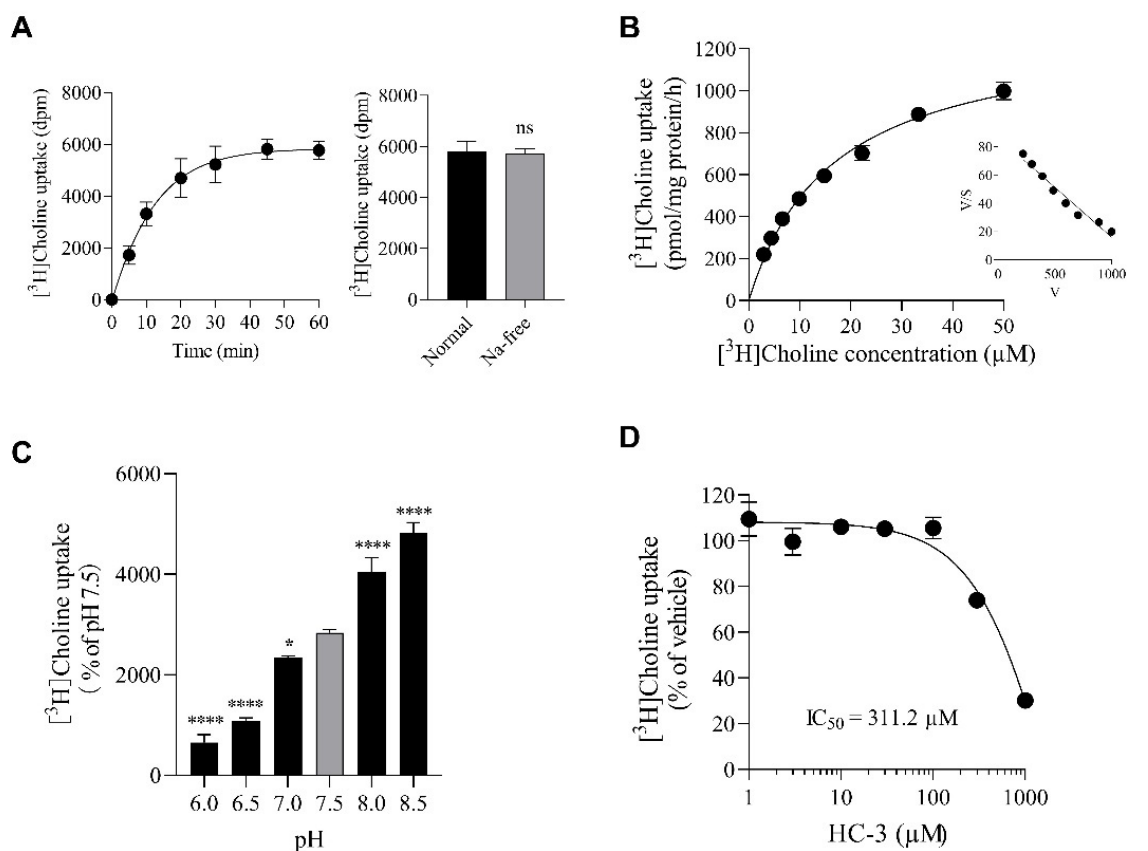
Figure 2. Characterization of [ 3 H]choline uptake in SIM-A9 cells. ( A ) Time course and Na + depend-